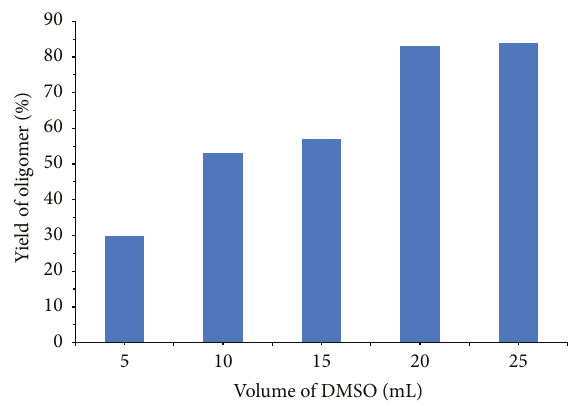
Figure 11: Effect of volume of solvent (DMSO) on the yield of oligomers (tetramer) [14].